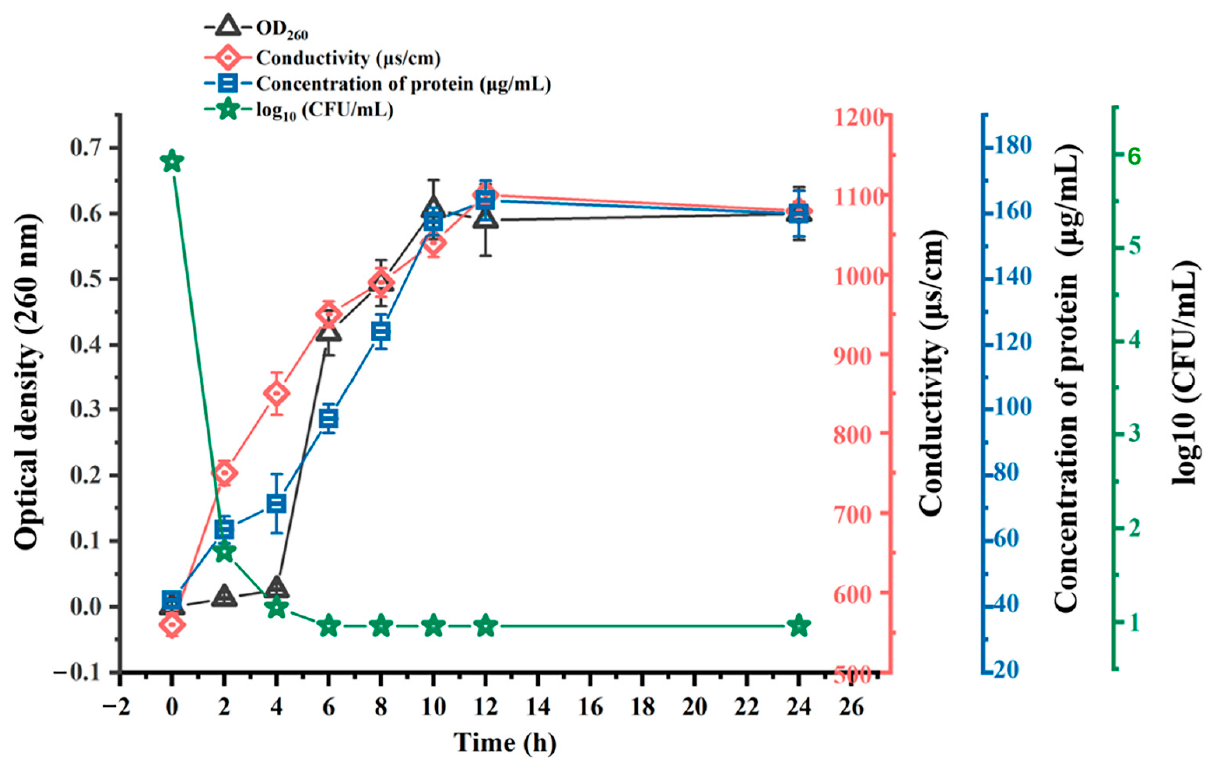
Figure 5. Mechanisms of action of BMGlv2 against C. perfringens CVCC 2032 including DNA leakage, protein leakage, alteration of conductivity, and bacterial counts. Results were given as the mean ± SD.